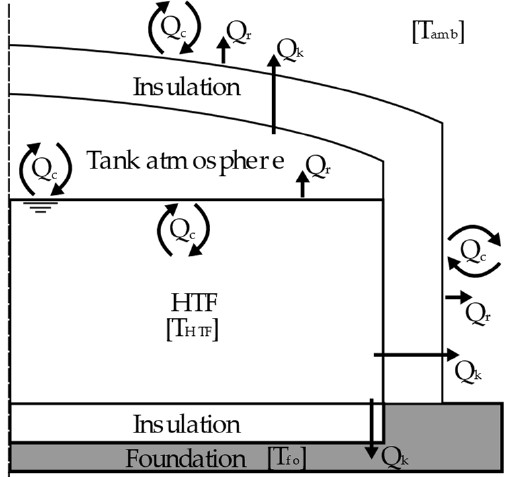
Figure 3. The TES thermal loss mechanisms (adopted from